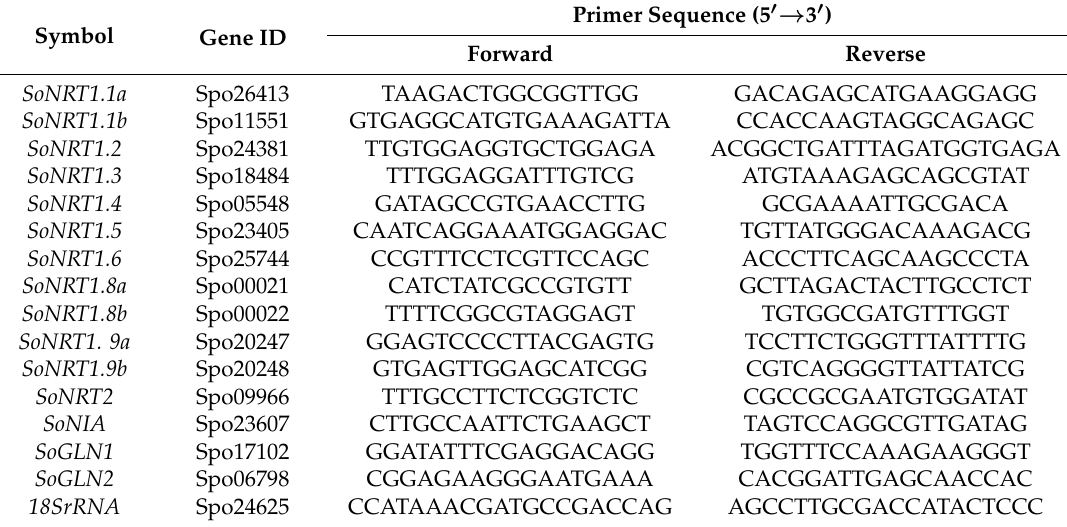
Table 4. Specific primers for NRT , NIA and GLN in